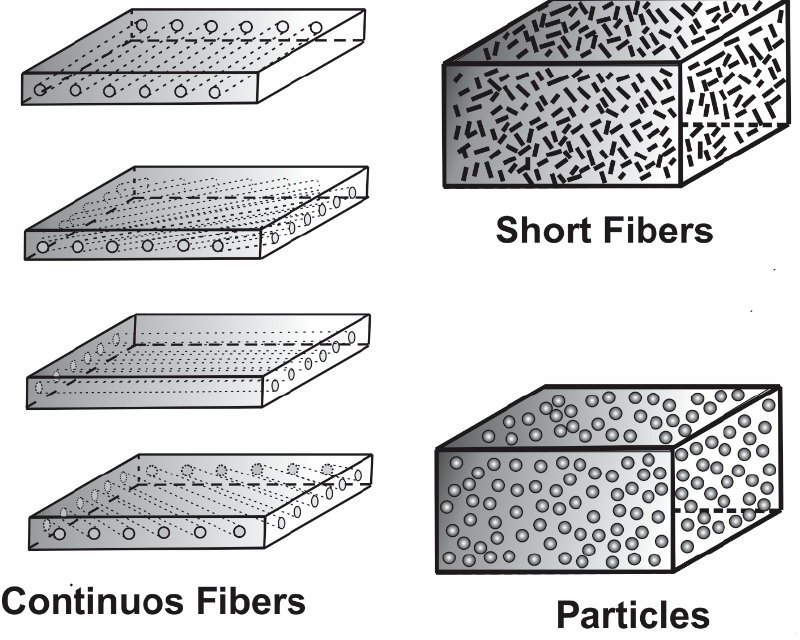
Figure 1. Types of composites reinforcements [10].